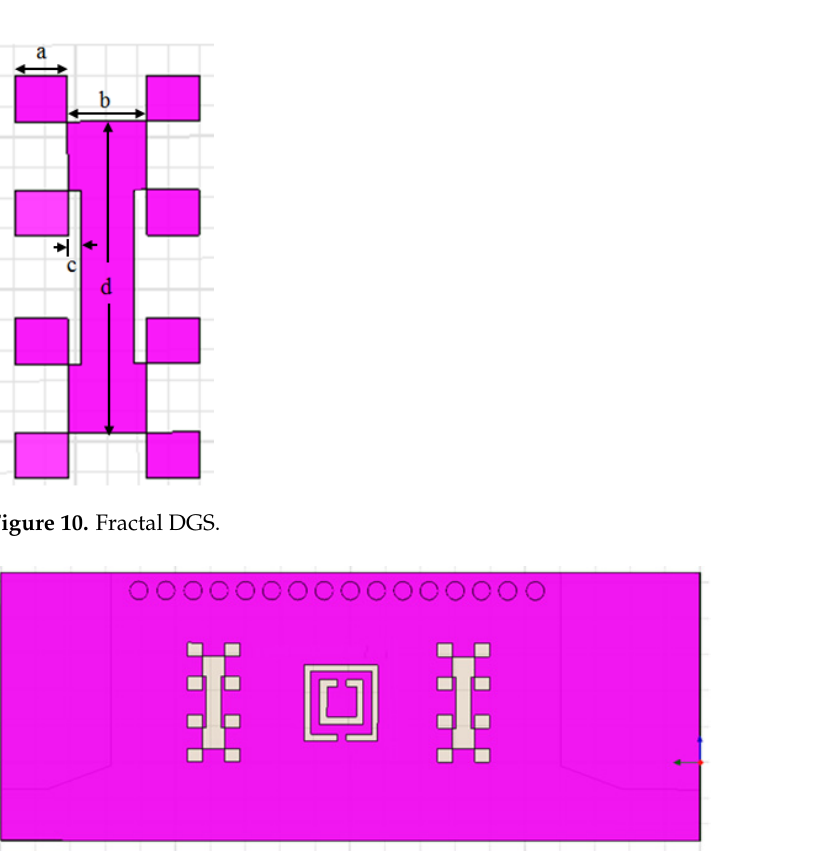
Figure 11. Bottom view of the proposed BPF with DGS and CSRR.